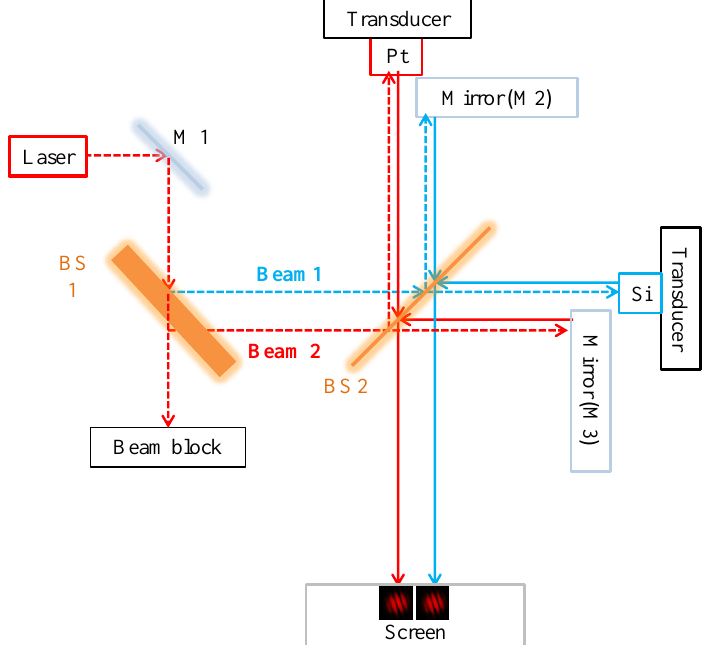
Figure 8. Dual beam Michelson interferometer. Beam Splitter 1 (BS1) splits the incoming laser beam into two passes for two pairs of interferences. Beam 2 is reflected on the rear surface of BS1. Light reflected on the Si/Pt specimen surface interferes with light reflected on M2/M1. Two interferometric fringe patterns are formed on the screen simultaneously. Respective specimens and corresponding mirrors are aligned for fringe formation, as explained in Figure 2. The screen is placed at a distance for better alignment of interfering light